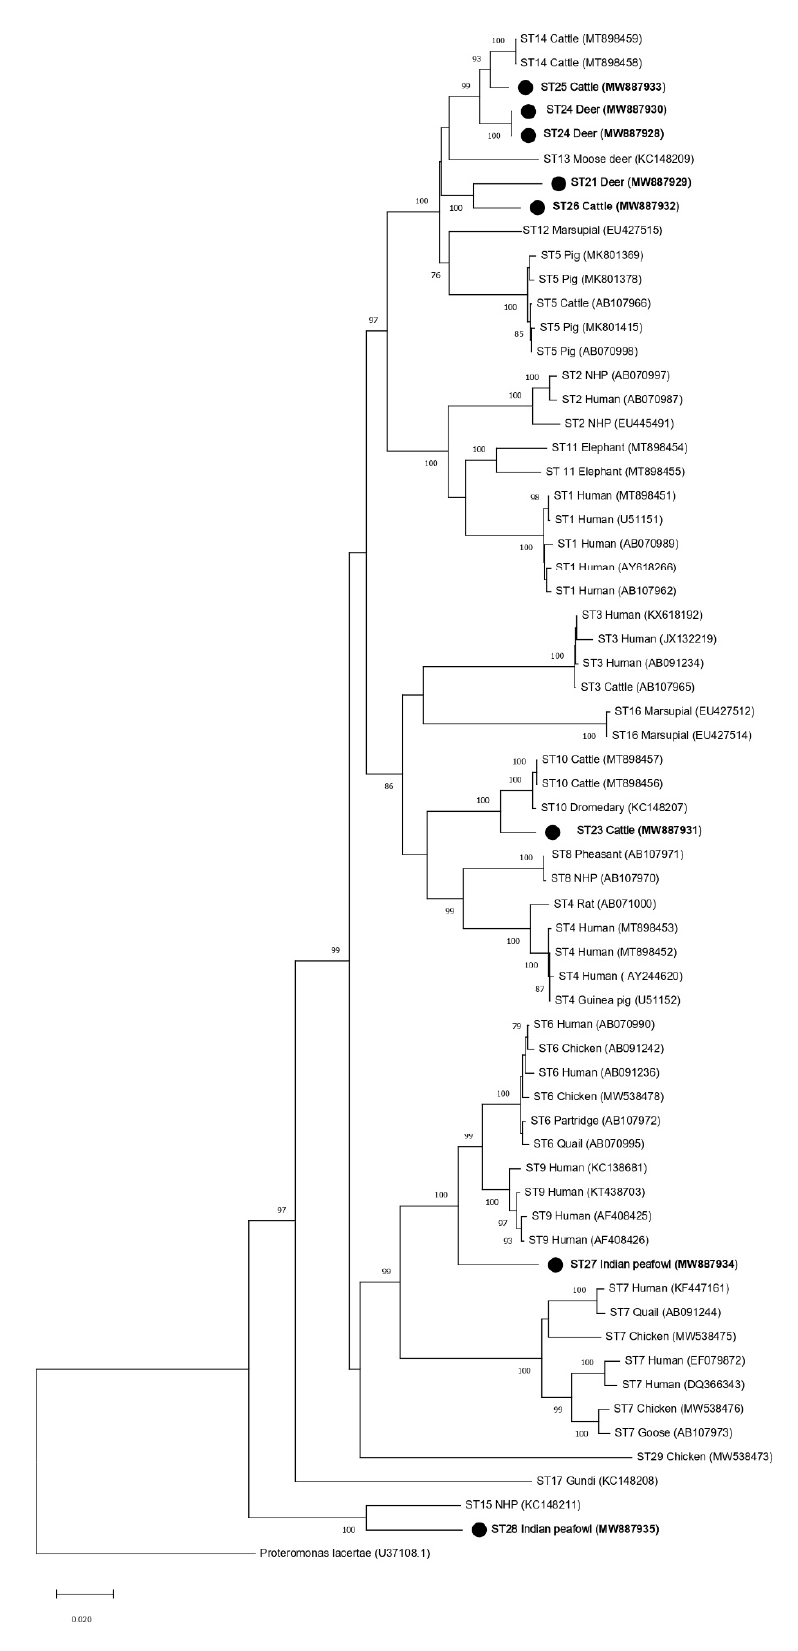
Figure 3. Phylogenetic relationships among Blastocystis full-length SSU rRNA gene nucleotide sequences generated in the present study (represented with a black filled circle) and